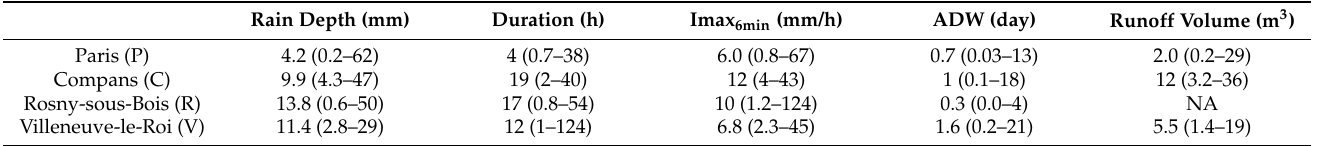
Table 3. Sampled rain event characteristics—median